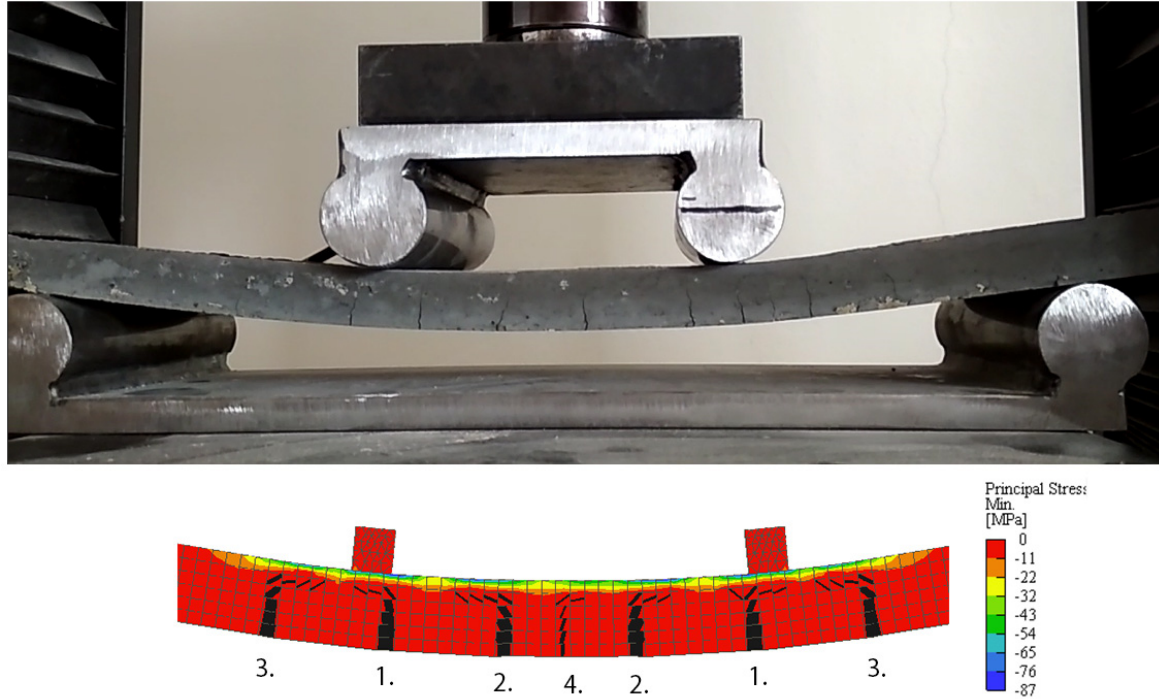
Figure 2. Comparison of crack development during real performed four-point bending test and detailed crack development output from the numerical analysis using Atena Engineering software. The order of the crack initiation is marked and the orientation and width of each crack is indicated. Distance of support is 300 mm, distance of loading support is 100 mm.